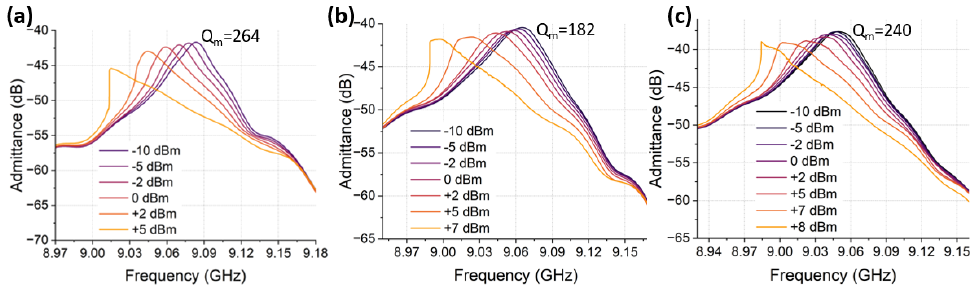
Figure 15. A- f response of SHF CLMRs at different power levels ( − 10 dB to +8 dB) : ( a ) A- f response of CLMR with narrow anchors. ( b ) A- f response of CLMR with medium anchors. ( c ) A- f response of CLMR with wide anchors.